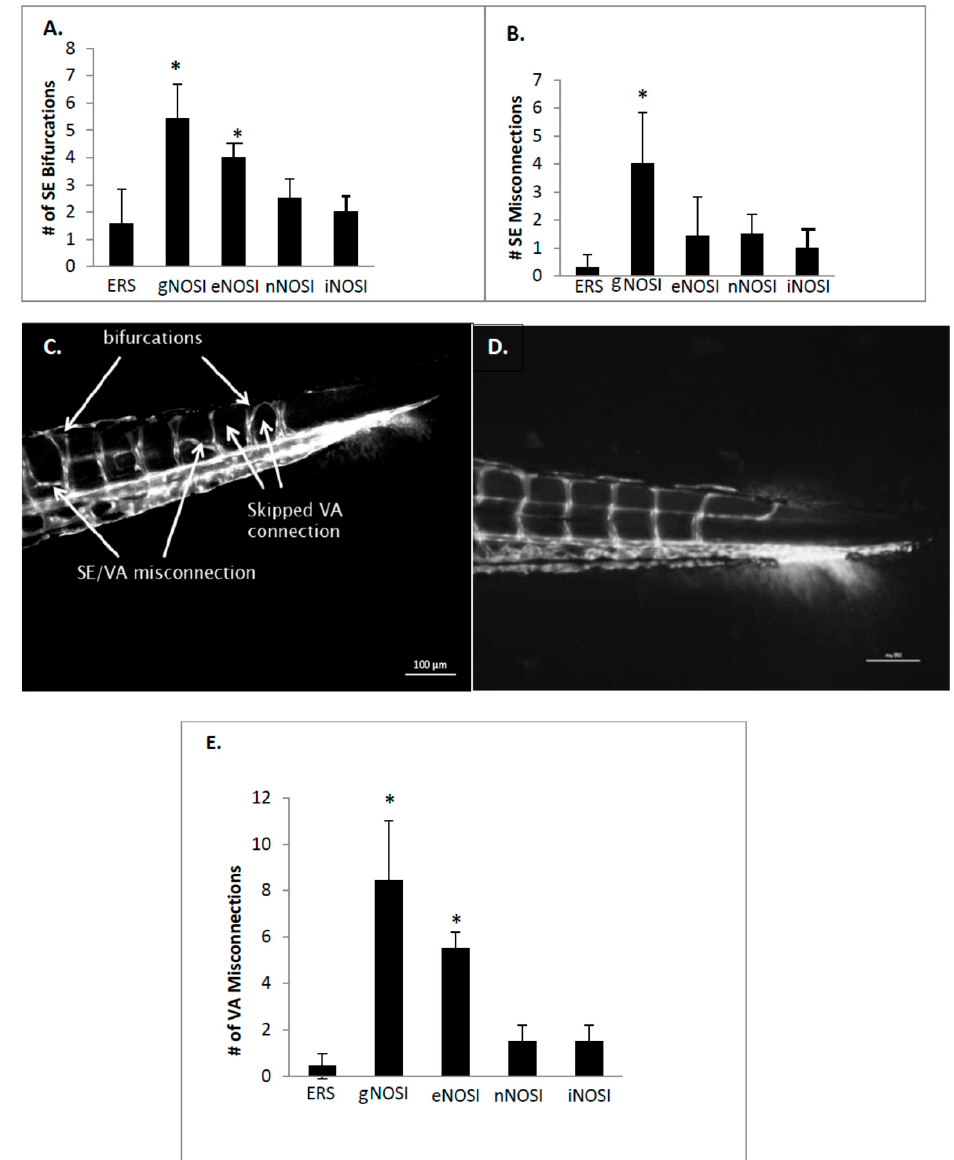
Figure 8. The effects of various treatments in TG(fli1:EGFP) y1/+y1 (AB) transgenic fish on average tail blood vessel measurements calculated from confocal z-stack photomicrographs after 4 days of treatment beginning at 48 h post fertilization (hpf). ( A ) This figure indicates that the number of intersegmental vessel (SE) abnormal bifurcations increases significantly when treated with gNOSI (15 mM) or eNOSI (5 µ M). Both treatments were significantly more effective than either nNOSI (50 µ M) or iNOSI (10 µ M) in causing this anomaly (* p < 0.001); ( B ) The number of SE misconnections increases significantly when treated with gNOSI compared to the control values (* p < 0.001). Also, gNOSI was significantly more effective than eNOSI, nNOSI, and iNOSI in causing this vessel anomaly (* p < 0.001); ( C , D ) Confocal z-stack imagery of the vasculature shows either retarded growth or deterioration, particularly in the dorsal longitudinal anastomotic vessel (DLAV) and vertebral artery (VA) vessels (arrows) in the various treated groups mentioned in A–B above which appear patchy or absent (arrows) when compared to control fish as seen in D; ( E ) Treatment effects on vertebral artery (VA) development demonstrates significant numbers of misconnections when treated with gNOSI and eNOSI compared to the control values (* p < 0.001). Also, note that both eNOSI and gNOSI were significantly more effective than nNOSI and iNOSI in perpetuating this vessel anomaly (* p < 0.001). Bars = ± SD. The data indicated in A, B, and D above was collected from the last 875 µ M of the caudal area.